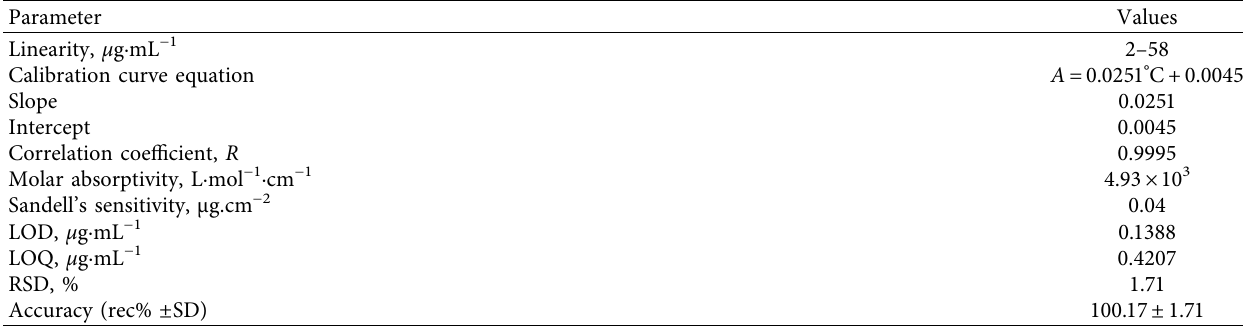
Figure 7: Calibration graph of LD determination using the proposed procedure. Table 3: Analytical parameters for the determination of LD (Ni-LD-DAP).